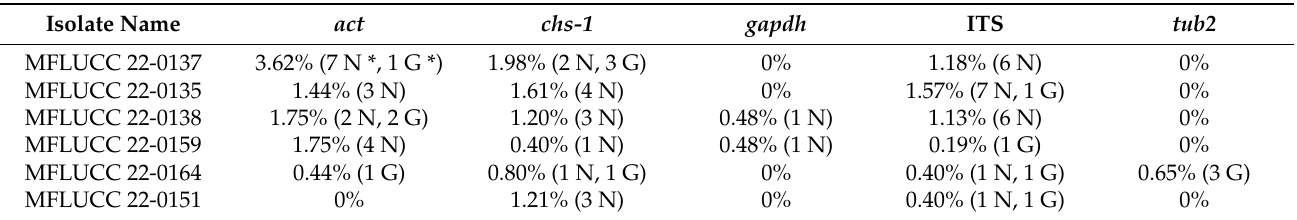
Table 1. Pairwise differences of the DNA sequences data of the ex-type strain with strains obtained in this